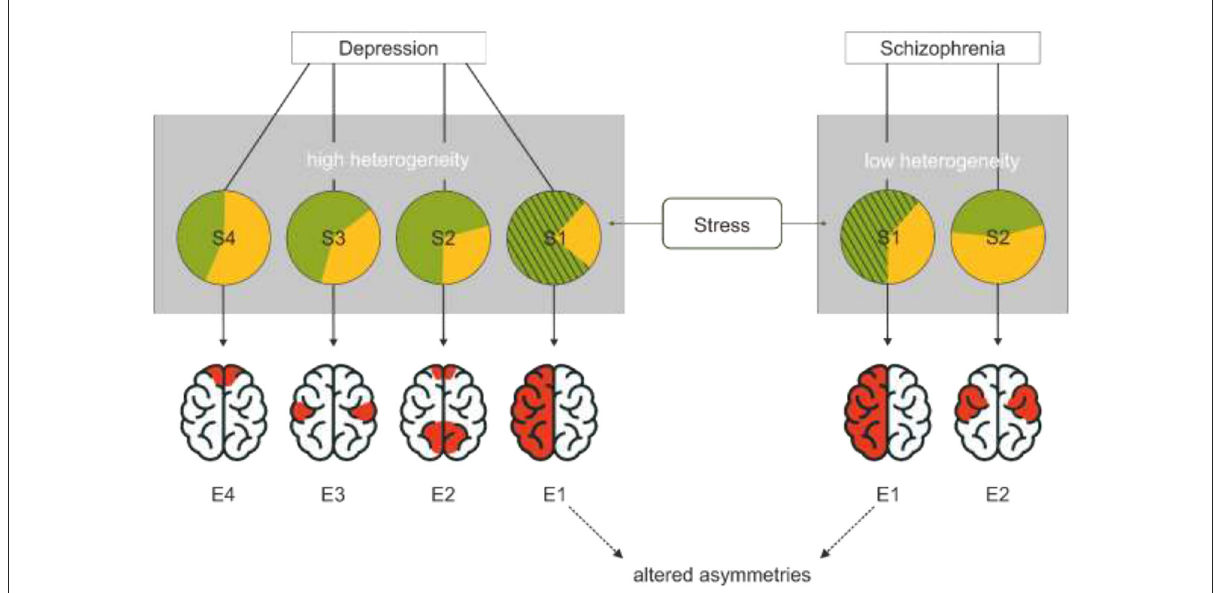
FIGURE1 The association between variability of causes, endophenotypes and disorders. All these different symptom subtypes are subsumed under the same diagnosis (gray rectangles). Each circle represents a cluster of causes associated with different symptom clusters (S1–S4). Green indicates environmental influences while yellow indicates genetic influences. Different combinations of causes are possible for each disorder. A disorder with more distinct causation clusters forms more distinct symptom clusters. A disorder, in which only very specific clusters of causes lead to the clinical manifestation, fewer symptom clusters emerge. Different symptom clusters are associated with different endophenotypes. If only one phenotype is associated with altered asymmetry patterns, its probability of occurrence is lower for disorders with more distinct subtypes and thus risk factors. This model suggests that stress, shown as the hatched partial circle, is an environmental risk factor that specifically promotes the emergence of the endophenotype with altered asymmetries. This endophenotype refers to reduced typical asymmetries; in the case of depression, frontal alpha asymmetries would constitute a prime candidate while asymmetries in the language system are more central in